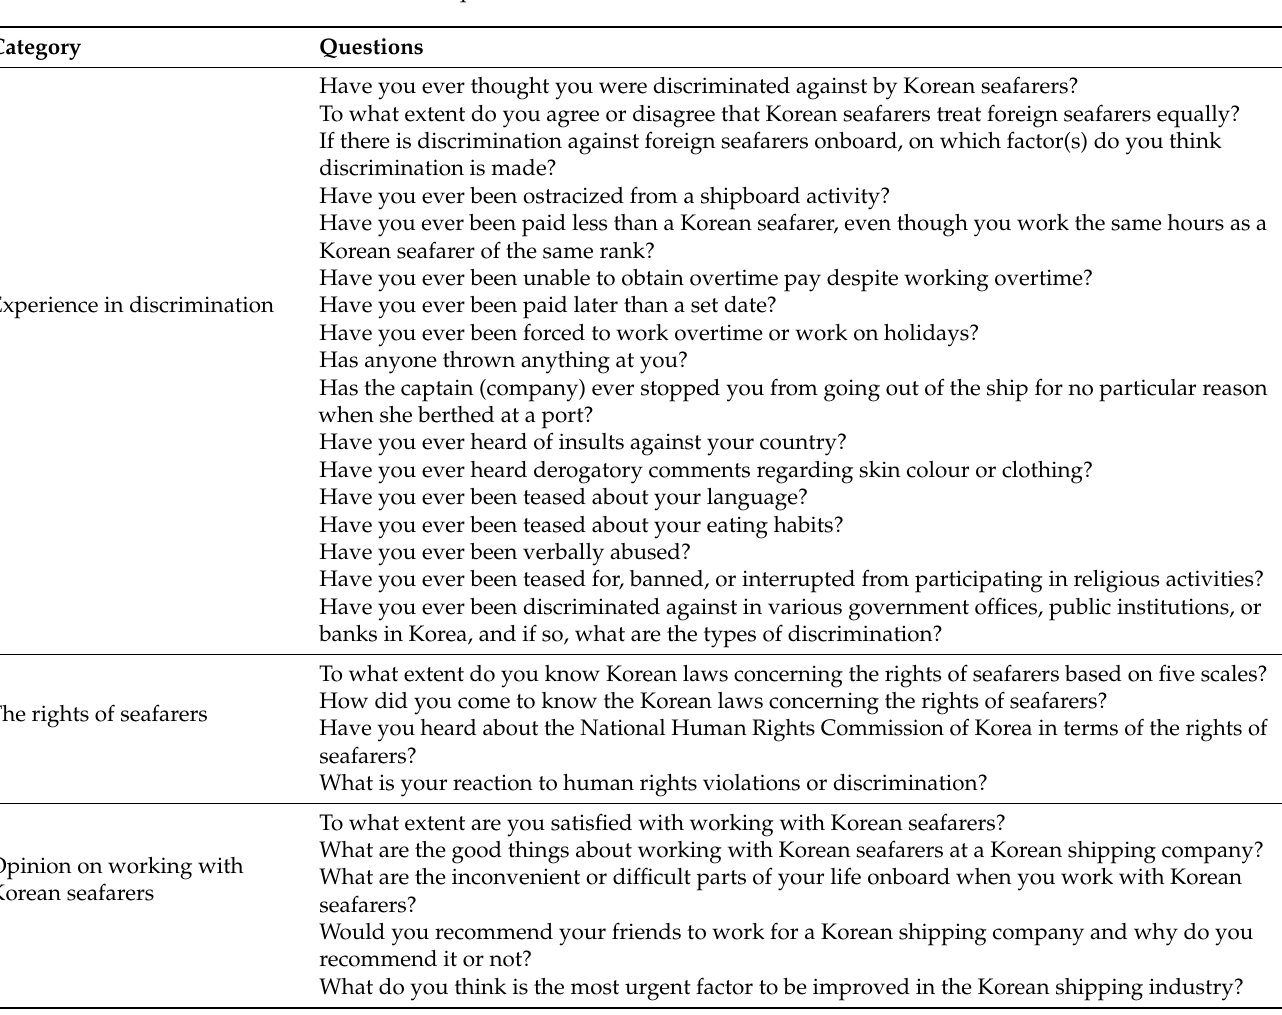
Table 2. List of questions.